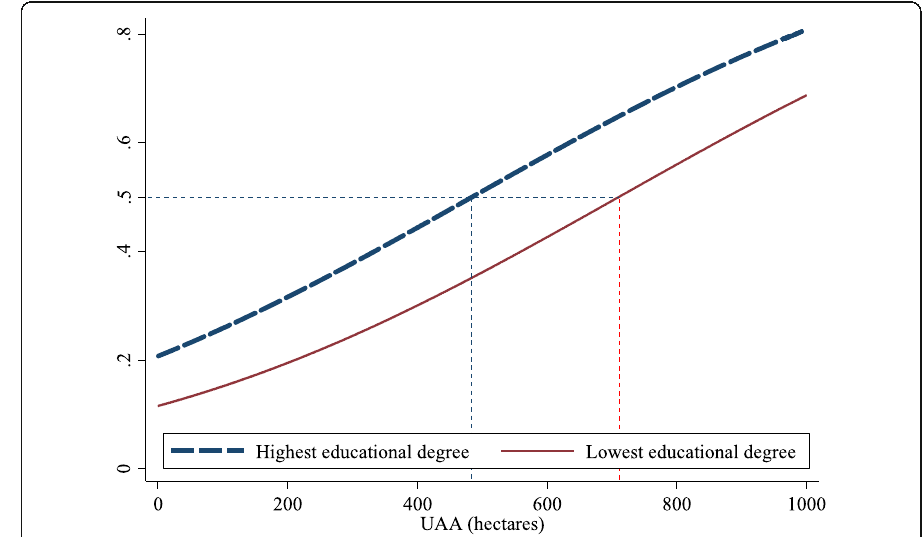
Fig. 1 Estimated function of propensity for a farm to be vertically